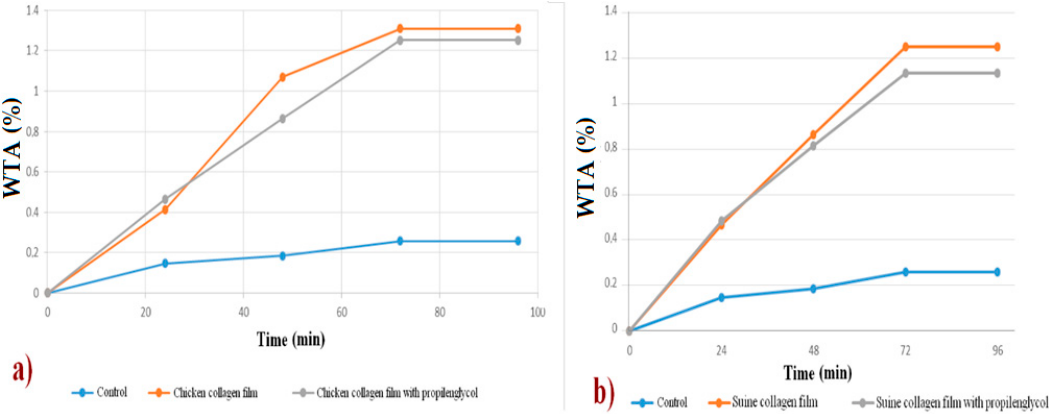
Figure 10. Water vapor transmission rate ( WVT ) test for films sample obtained from ( a ) chicken collagen samples and ( b ) swine collagen.